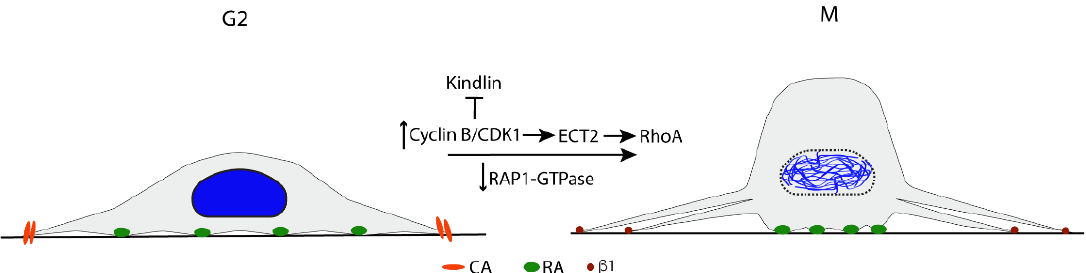
Figure 3. The schematic side view picture indicates cell rounding and the remnants of cell adhesions. The activation of cyclin B/CDK1 and the downstream degradation of kindlin and activation of the RhoA pathway, together with the inactivation of RAP1-GTPase are described as the main mechanisms for cell rounding in mitosis.